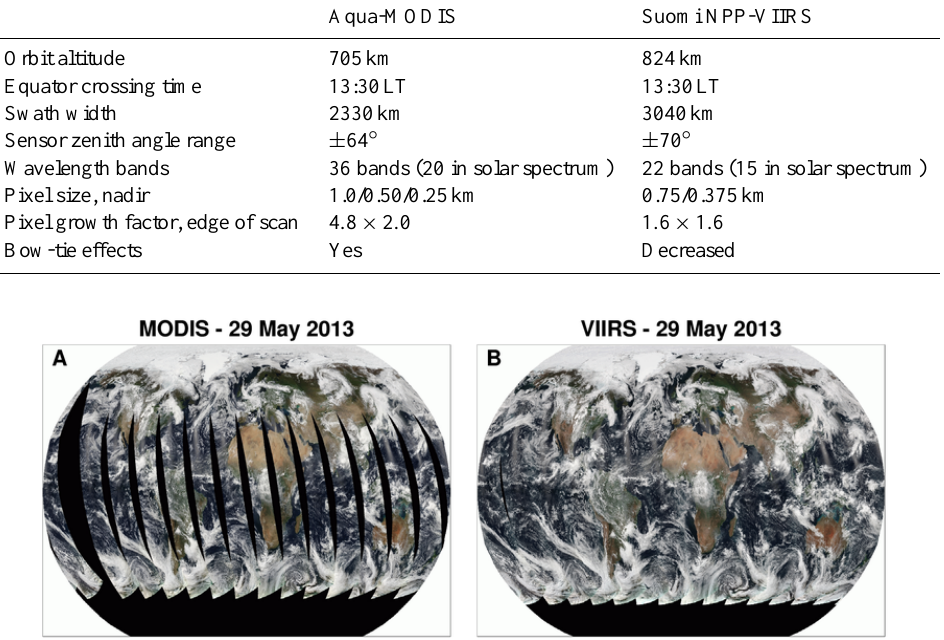
Table 2. MODIS and VIIRS instrument specifications.